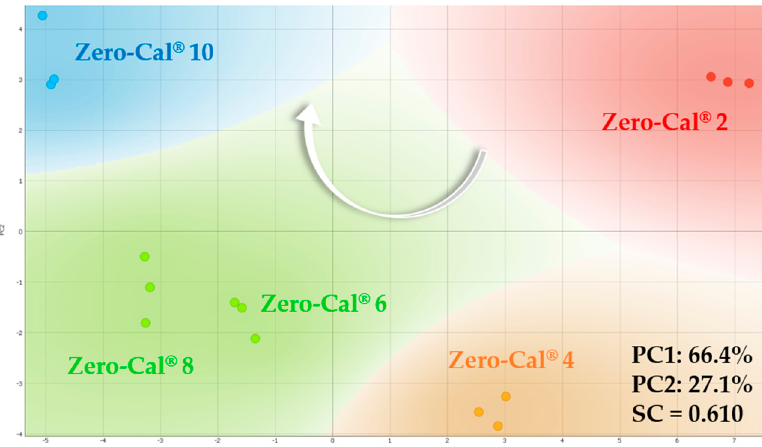
Figure 19. PCA plot for Zero-Cal ® at distinct concentrations in espresso coffee (from 2 to 10 µL/mL) obtained using the impedimetric microfluidic e-tongue at 5 mL/h flow rate. The number in front of the Zero-Cal ® brand represents the respective concentration and the white arrow indicates the direction of increasing concentration.